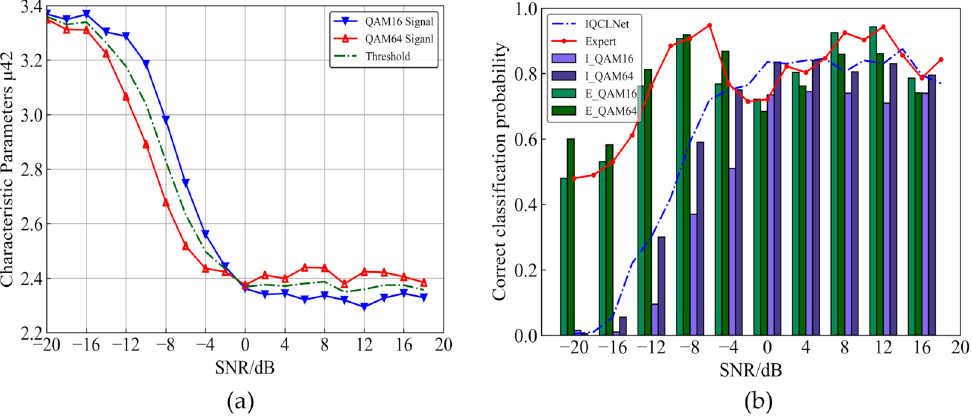
Figure 7. Experimental results of the expert feature method. ( a ) Characteristic parameter µ 42 ; ( b ) results of IQCLNet and expert feature methods in identifying QAM, respectively.